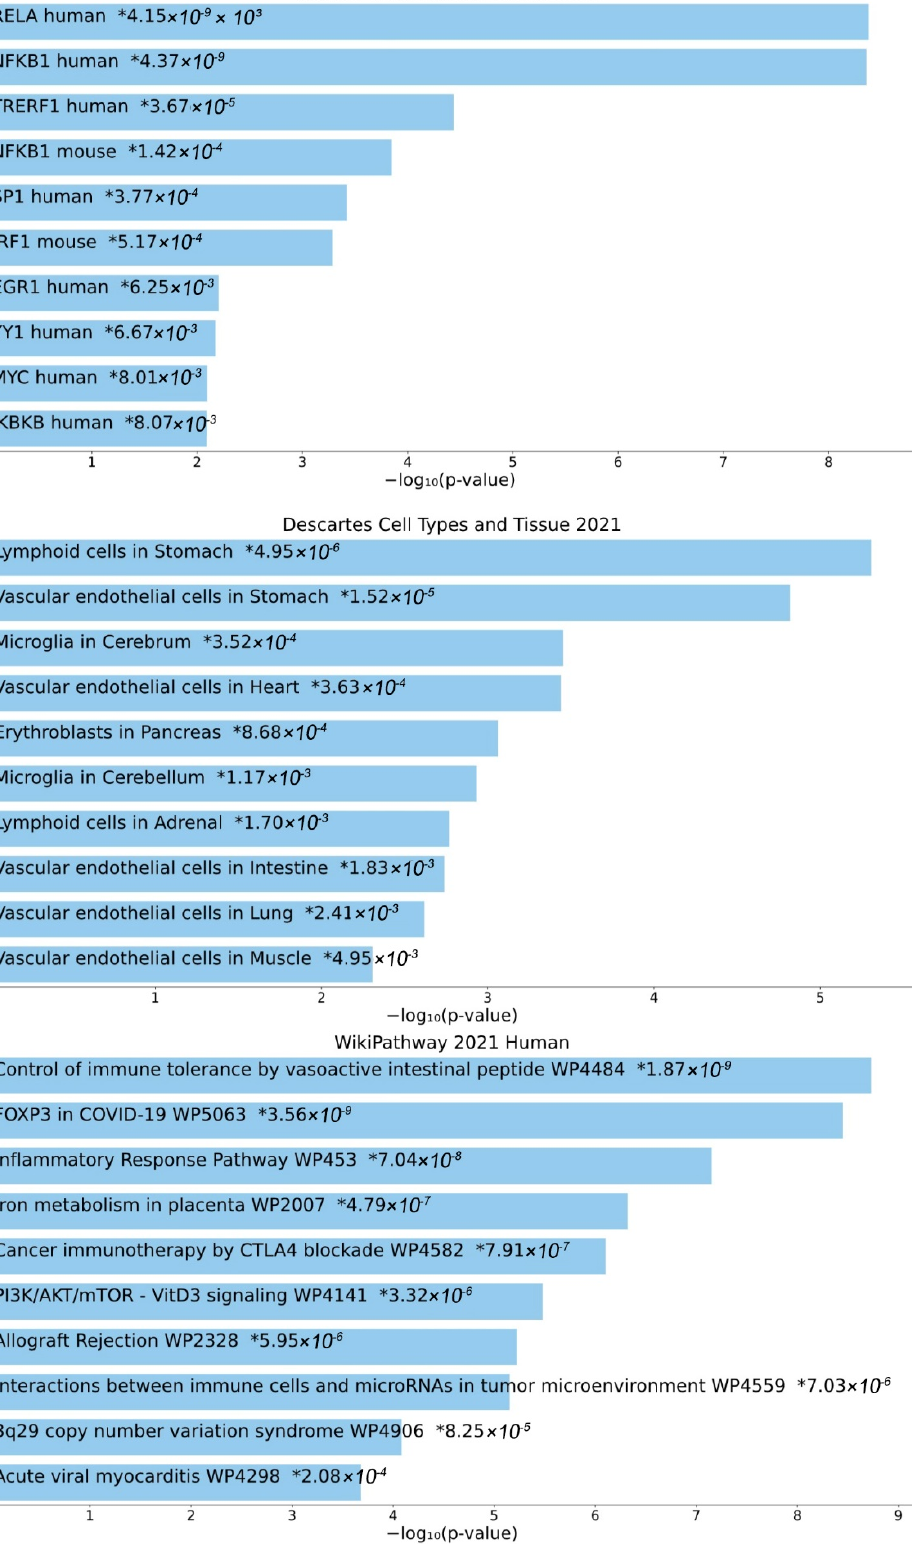
Figure 4. Transcription factors, cell types, and pathways associated with GTN genes. Top 10 enriched transcription factors (TRRUST Transcription Factor Database version 2019), cell types (Descartes Cell Types and Tissue Database version 2021), and pathways (WikiPathways Database version 2021), based on Enrichr analysis. Individual asterisks denote p -values.